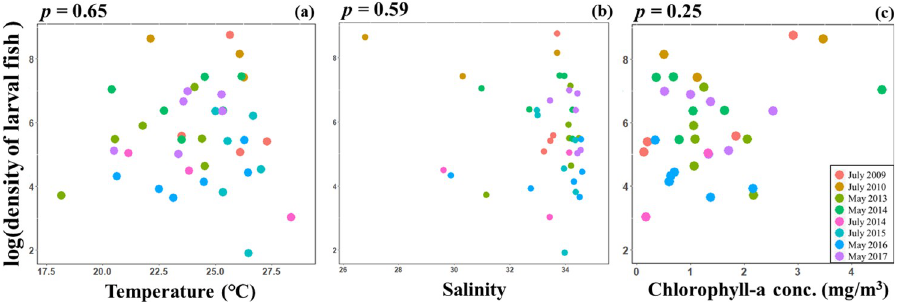
Fig 4. Relationships between environmental variables and logged larval fish density. The environmental variables included (a) temperature, (b) salinity, and (c) chlorophyll-a concentration at the surface layer. Colors indicate different cruises. None of the relationships were